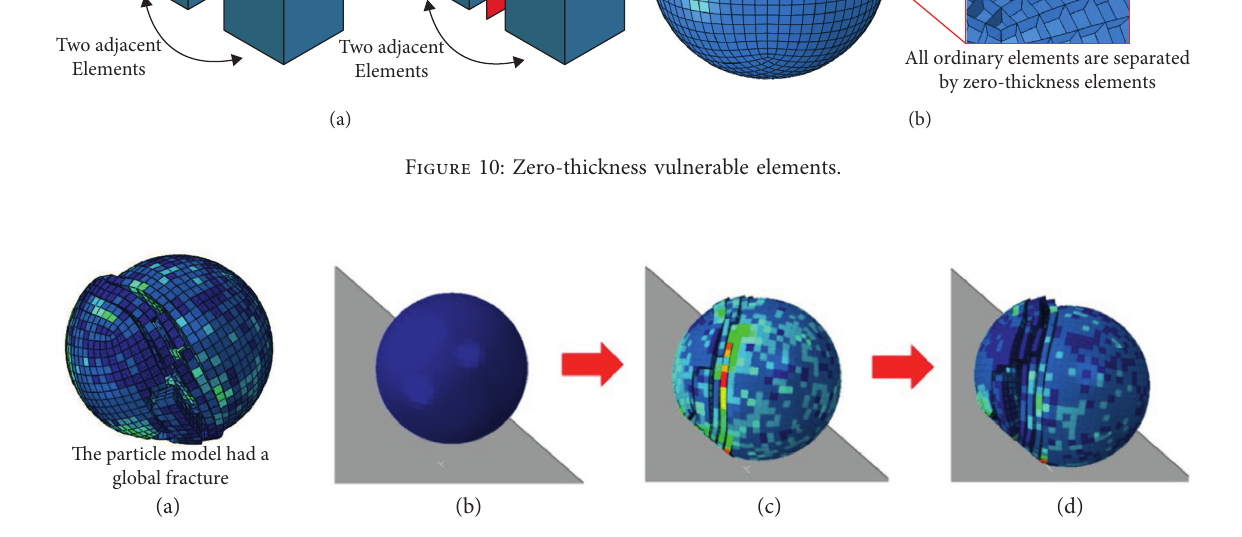
Figure 11: Impact effect diagram of Model 3.